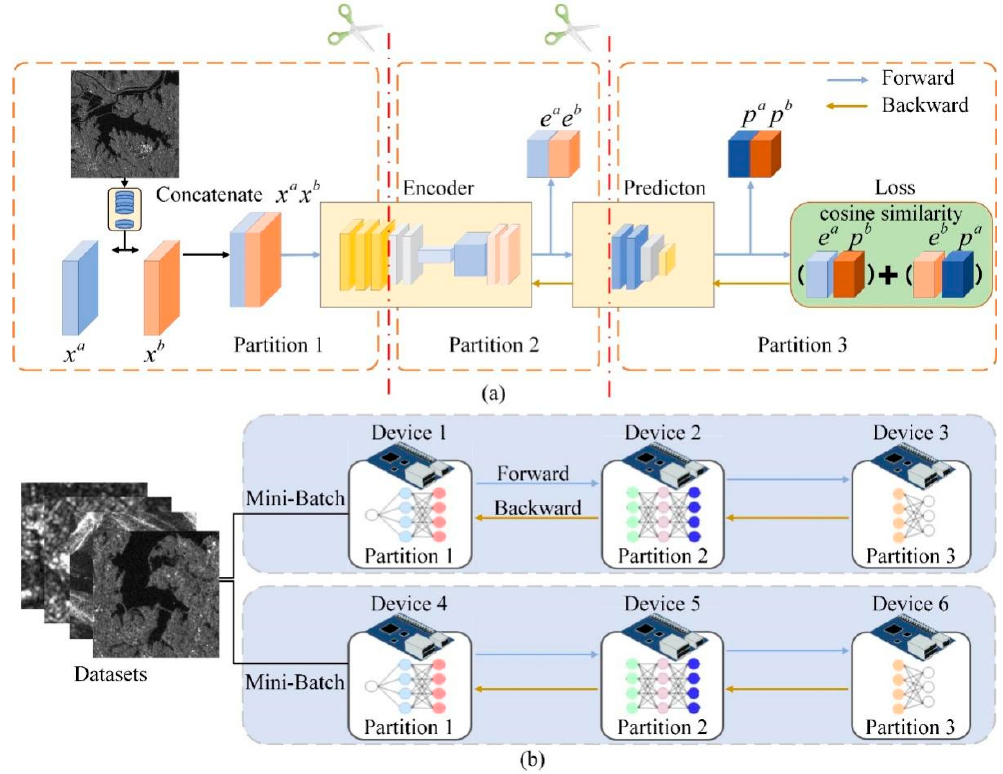
Figure 3. ( a ) We design the training process of Lite-SRL as a sequential structure to adapt model parallelization. ( b ) Schematic of the proposed distributed hybrid parallel (DHP) training baseline.